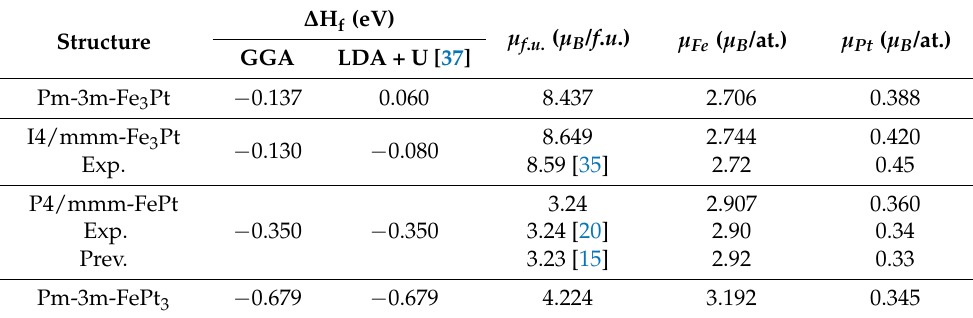
Table 2. Calculated heats of formation ( ∆ H f ) and magnetic moments ( ¯ ) for the Fe-Pt alloys.